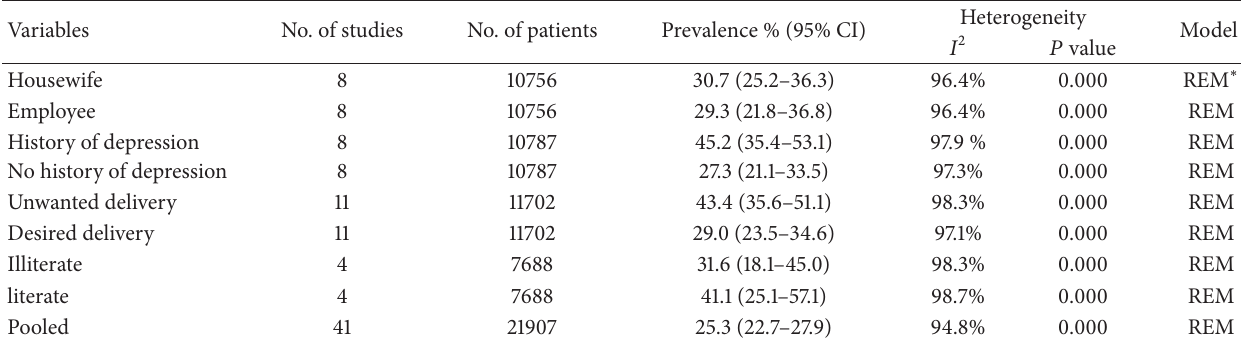
Table 2: Prevalence of postpartum depression among subgroups.